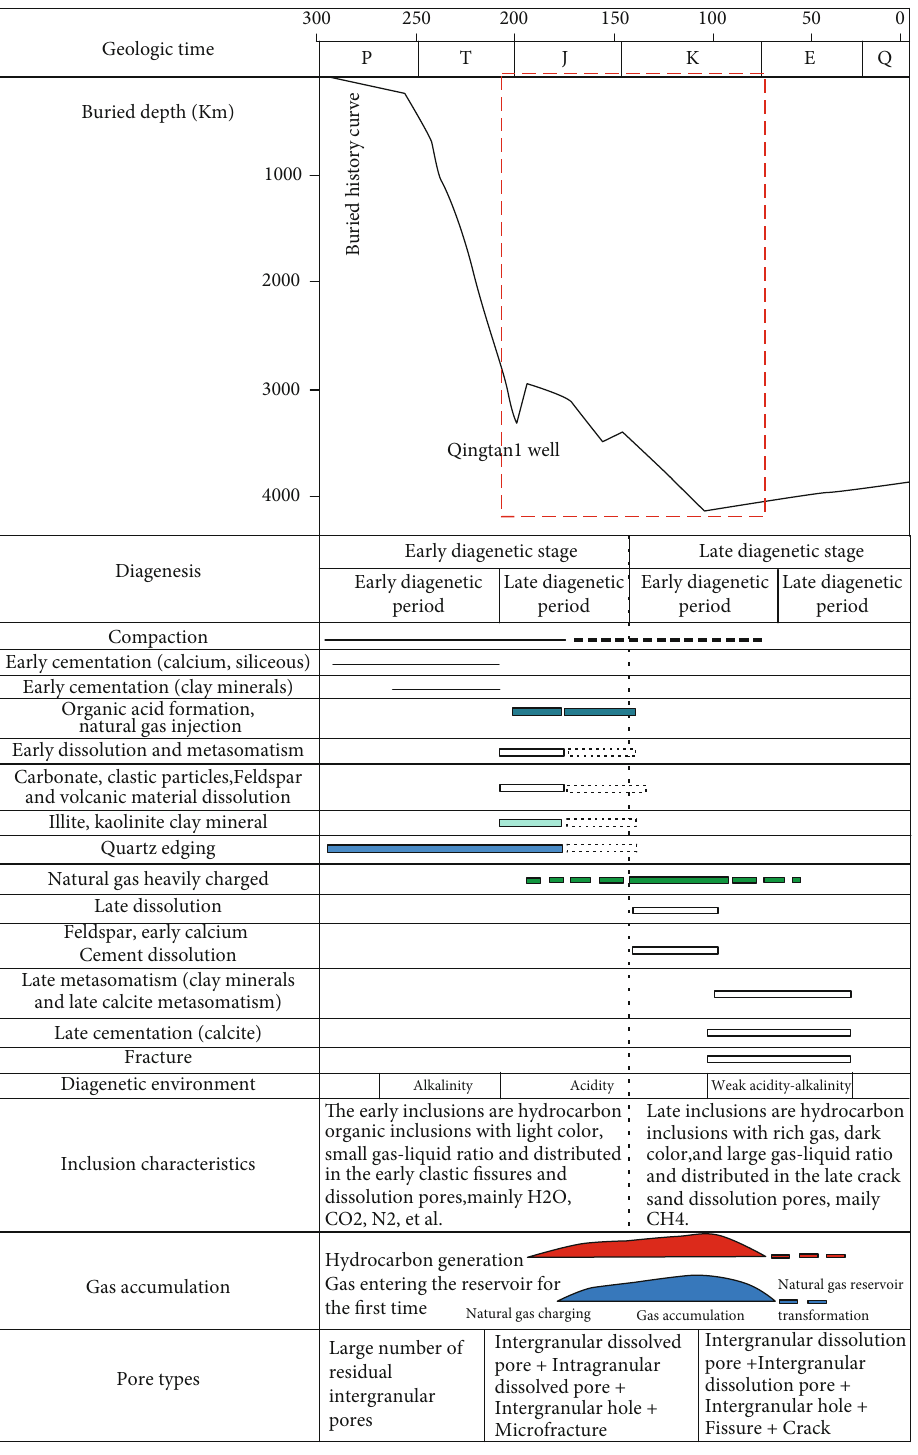
Figure 10: The diagenetic evolution sequence and accumulation history of the sandstone reservoir in the Upper Paleozoic Erathem of the Qingtan 1 drilling